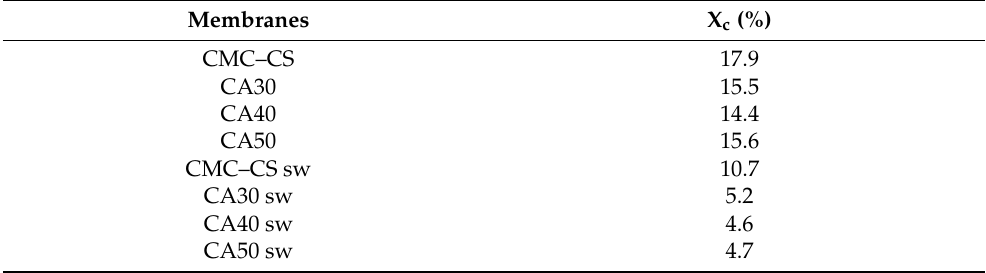
Table 2. Crystallinity degree (X c ) calculated from the XRD patterns.